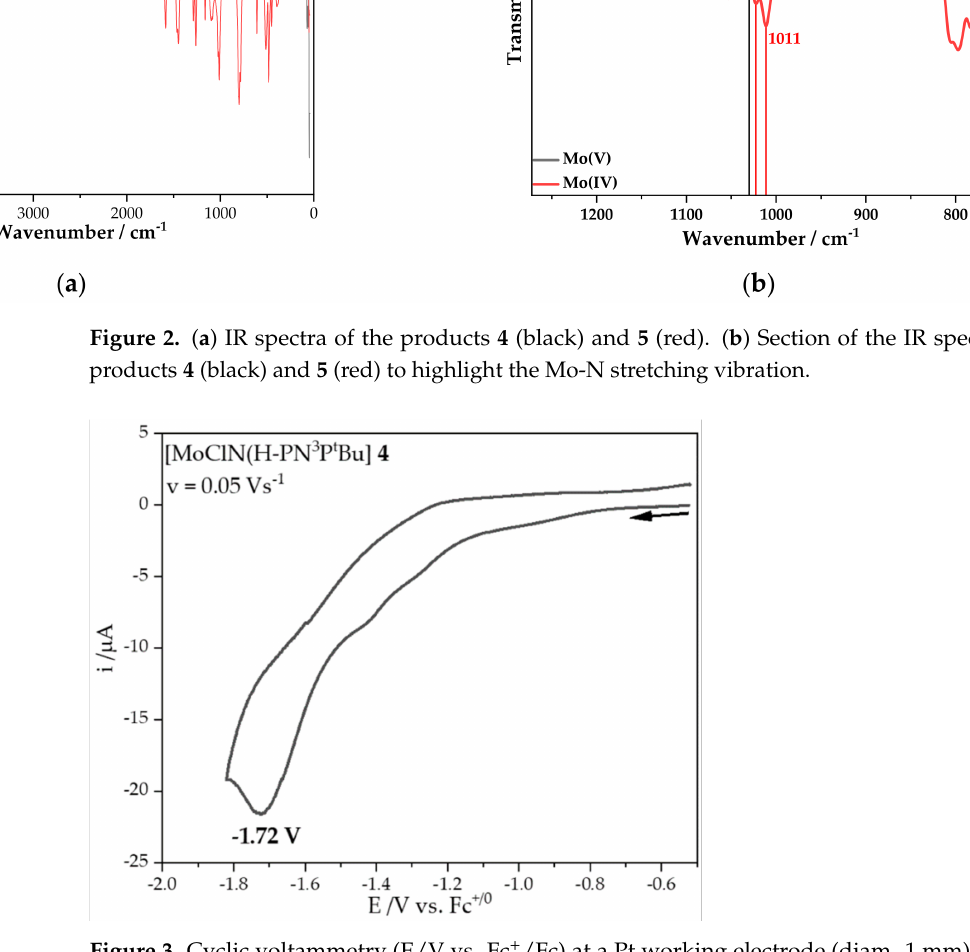
Figure 3. Cyclic voltammetry (E/V vs. Fc + /Fc) at a Pt working electrode (diam. 1 mm) of Mo(V)- nitrido 4 (1 mM) in THF/NBu 4 OTf (0.1 mM) at 0.05 Vs − 1